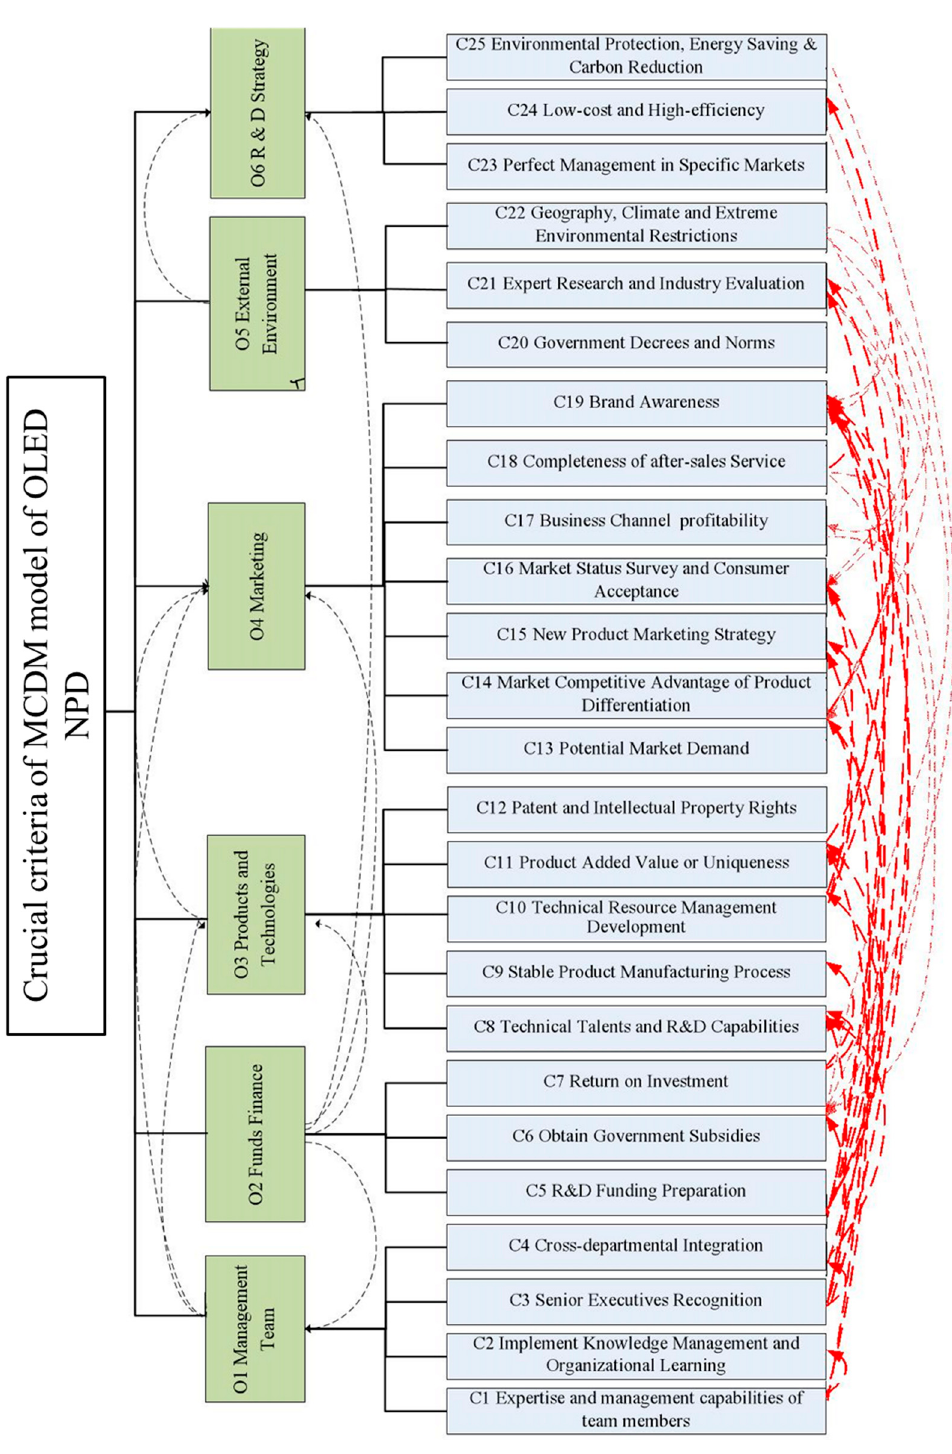
Figure 2. The ISM hierarchy diagram for OLED NPD. Table 8. The result of reachable set and antecedent set.